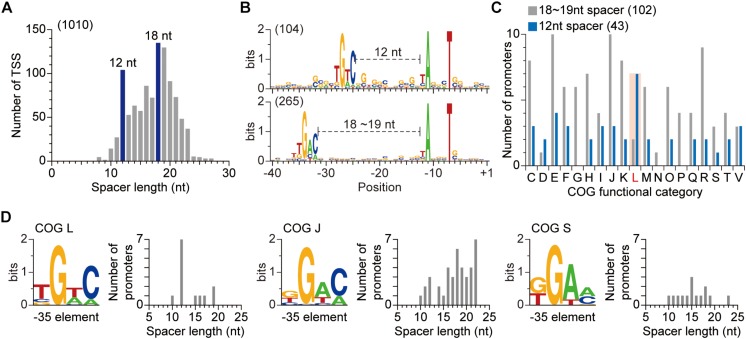
Relationship between promoter sequences and the function of the corresponding gene. (A) The spacer lengths of S. lividans TK24. The spacer length was calculated for transcription start sites whose −10 and −35 elements were simultaneously discovered. (B) Differences in promoter sequences with different spacer length. (C) Functional analysis of genes exploiting two different types of promoter. Genes with 12 nt spacer are functionally enriched in COG category L, which represents DNA replication, recombination and repair. (D) Variation of −35 element sequence and spacer length dependent on the function of genes.